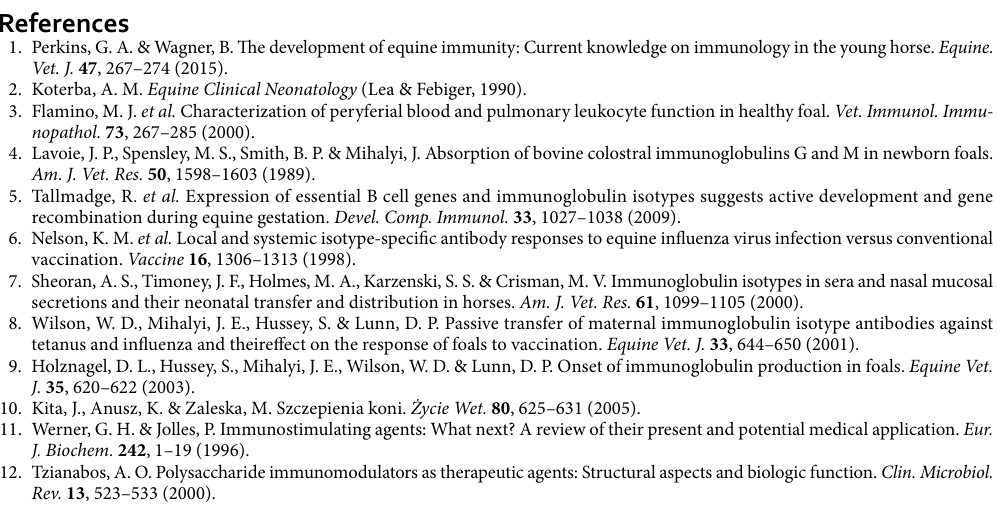
Table S3). 100 µl of plasma per well were added. Each well was washed three times with Assay Buffer after each step. 100 µl of working dilution of Detection Antibody were added and incubate 1 h. After wash 100 µl of work- ing dilution of Conjugate were added to each well and incubated for 20 min. After the wash, 100 µl of Substarte Solution were added to each well, and incubated for 20 min. After the wash, 50 µl of Stop Solution were added to each well. Duplicate wells were used for each sample. Plates were read using microplate reader set to 450 nm. Results were calculated based on standard curve. High standard concentration of 20 ng /ml for IgG2 and 2520 ng /ml for IgM were prepared, vortexed for 15 s, and allowed to sit for 5 min. A seven-point standard curve was generated using twofold serial dilutions in the Assay Buffer. Statistical analysis. Data are presented as means ± standard error. The data were analysed using SAS 9.4 software (SAS Institute INC., USA). The Shapiro–Wilk test was considered the best test to check the normality of the distribution of a random variable. Because the data did not have normal distribution, Kruskal–Wallis test was used, with immunostimulant as effects and for interactions between group and time post-immunization on relative antibody concentration and cytokine and mRNA expressions. The relationships between all parameters (TLR4 mRNA expresion level, concetration of IL-10, IL-6 ang IgG2, IgM) were analyzed using nonparametric Spearman’s rank correlation test. The value ranges from 0.0 to 0.5, from 0.5 to 1.0, from − 0.5 to 0.0 and from − 1.0 to − 0.5 indicate weak positive, strong positive, weak negative and strong negative correlation, respectively. Ethics committee. The authors have declared: Experiment with animals were carried out according to the ARRIVE guidelines (McGrath et al. 2010); The protocol was approved by the Dean Faculty of Animal Sciences, University of Agriculture in Krakow (no 37, 30 May 2016); Veterinary care and samples collecting were per- formed by vet prof. Adam Okólski; All animals used in this study were help in experimental station of University of Agriculture in Krakow; All methods were carried out in accordance with relevant guidelines and regulations. Ethical approval.